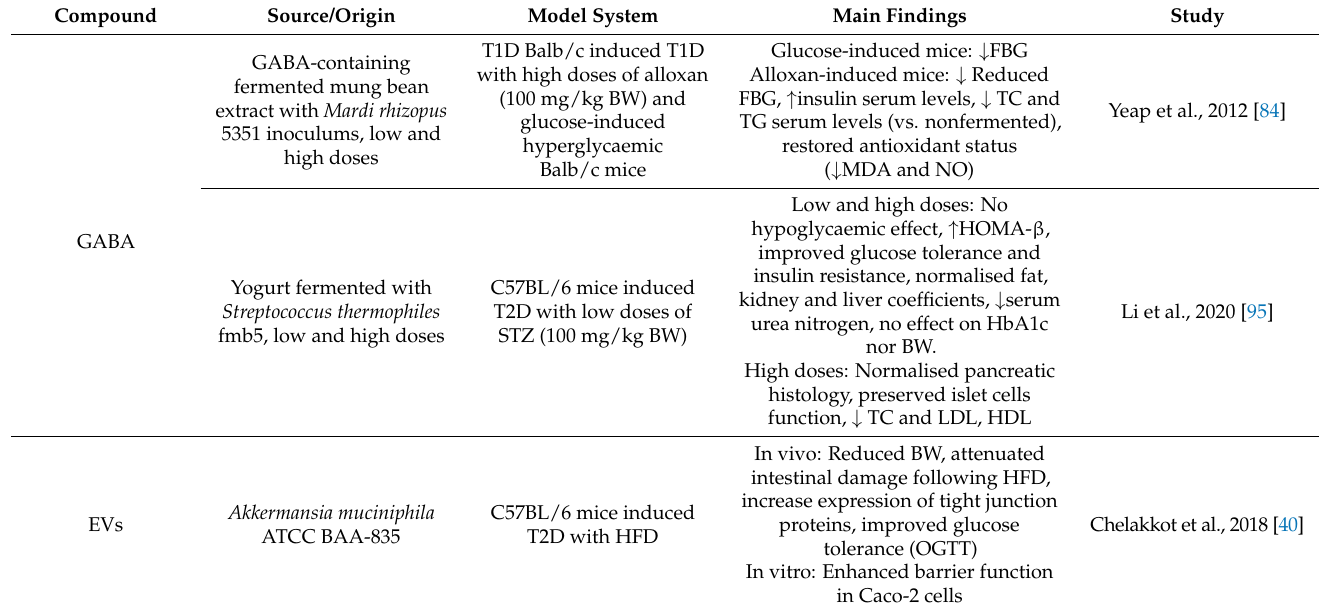
Table 2. Experimental studies on the effects of GABA and EVs in diabetes